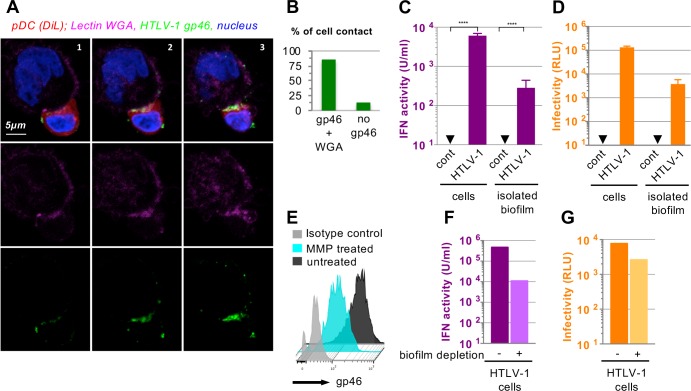
HTLV biofilm-like structures trigger a robust activation of pDC-IFN-I response.A. Representative confocal imaging of pDC/HTLV-1 infected cell contact with 3 consecutive Z-stack sections (left to right, all immunodetections were performed without permeabilization). Upper panels, confocal analysis of HTLV-1 Env gp46 (green) that form cluster at the contact between HTLV-1 infected cells and pDCs (stained with DiI, a lipophilic dye, red). Carbohydrate-rich structures are stained by the WGA lectin (Triticum vulgaris, purple), and nuclei are stained with Hoescht (blue). Middle and lower panels, single detections of WGA lectin and HTLV-1 Env gp46, respectively. B. Quantification of the presence or not of Env gp46 and WGA co-clusters at the cell-cell contact (analysis of 16 cell-cell contacts in 3 independent experiments). C-D. Parallel quantification of IFN-I activity in SNs of pDCs co-cultured with HTLV-1-infected cells (C91-PL) versus biofilm-like structures isolated from HTLV-1-infected cells (C91-PL) and infectivity transmission levels, determined as in Figs 1G and 2D (mean ± SD; 3 independent experiments performed with similar viral capsid levels in the isolated HTLV-1 biofilm-like structure as determined by p19gag levels, i.e. 2.9 ng). Asterisks indicate statistically significant differences calculated using ANOVA followed by Sidak’s multiple comparison test: **** p<0.0001. E. Surface Env gp46 detection on HTLV-1 infected cells (C91-PL) treated or not with metalloproteinase 9 (MMP-9; 20 nM). F-G. Parallel quantifications of IFN-I activity in SNs of pDCs co-cultured with HTLV-1-infected cells (C91-PL) treated or not with MMP-9 as in C, and infectivity transmission levels to Jurkat reporter cells co-cultured with HTLV-1-infected cells (C91-PL) treated or not with MMP-9 determined as in Fig 2D. The results are representative of 3 independent experiments.